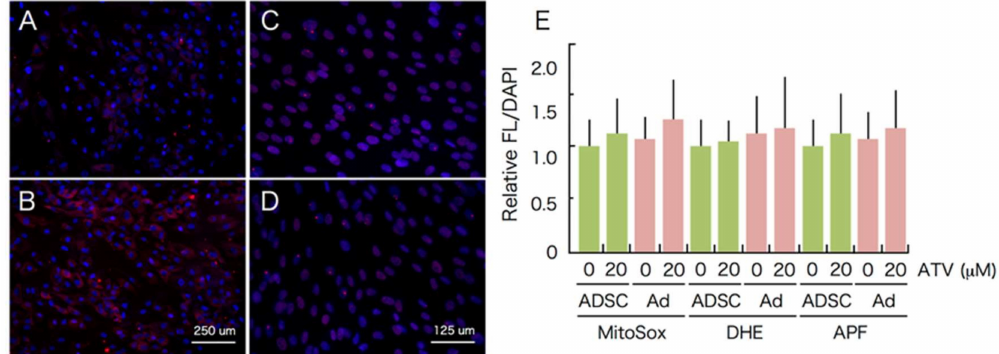
Figure 9. ROS and DNA damage induction during adipogenesis in the presence of ATV. ADSCs, cultured in a serum free medium until they reached confluence, were incubated in adipogenic differentiation medium for 7 days with 20 µ M ATV. After fixation, cells were incubated with MitoSox-red ( A , B ) or stained with anti-53BP1 antibody ( C , D ). ( A , C ) control, ( C , D ) 20 µ M ATV. ( E ) ADSCs were incubated in adipogenic differentiation medium for 7 days with 20 µ M ATV. After fixation, cells were incubated with MitoSox-red, DHE, and APF. Relative fluorescence was measured as described in Materials and